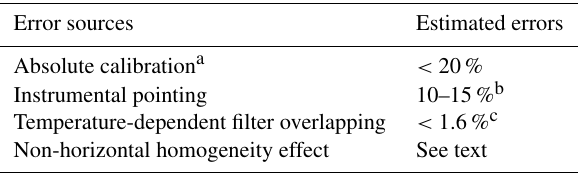
Table 1. A summary of the possible sources of systematic error in the IRI OH VER and their relative